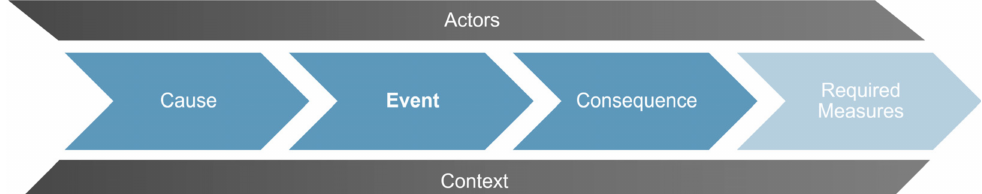
Figure 8. The chain of cause, event, and consequence provides the scaffolding for each scenario. In future iterations of the scenario catalogue, required measures may be added.